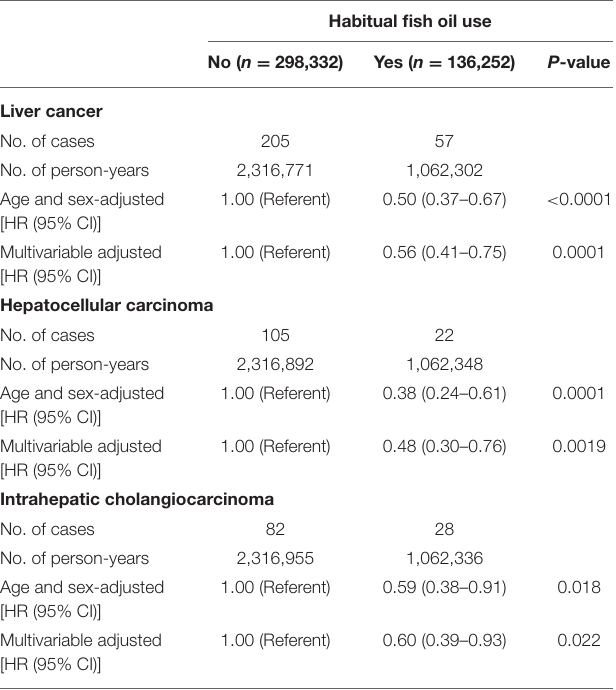
TABLE 2 | Association of fish oil use with the risk of liver cancer and its major histological subtypes.